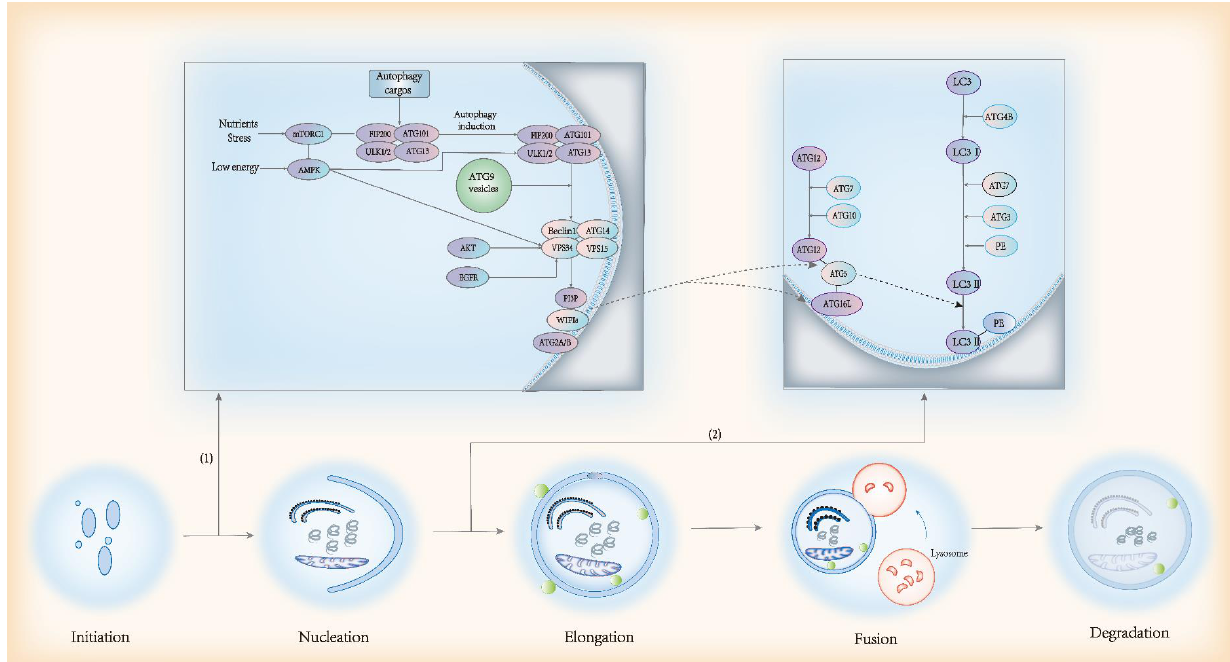
Figure 3. The classical process of autophagy. ( 1 ) Two types of activation signals (mTORC1 and AMPK activation signals and autophagic cargo activation signals) and proteasome complexes involved in the initial stage of autophagy. ( 2 ) Two ubiquitin-like conjugation systems involved in the elongation stage of